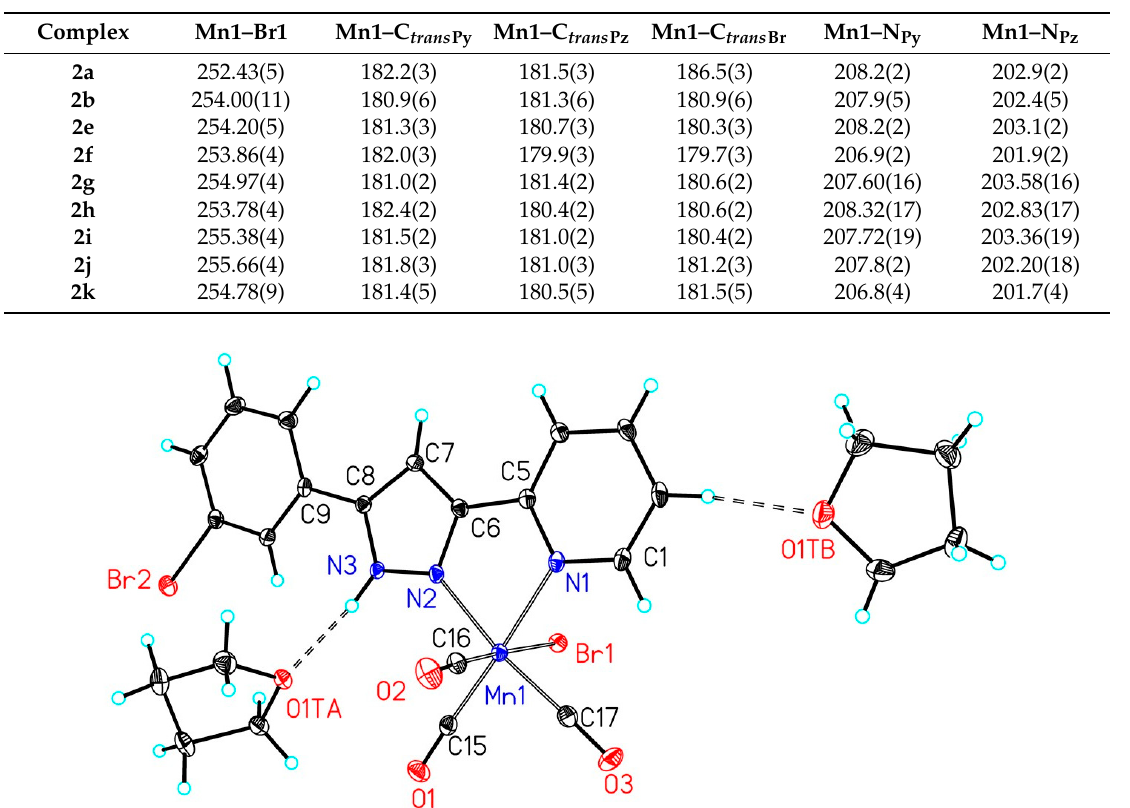
Figure 1. Molecular structure and numbering scheme of 2f ·2THF. The ellipsoids represent a probability of 30%, H atoms are drawn with arbitrary radii. Selected bond lengths are listed in Table 2.